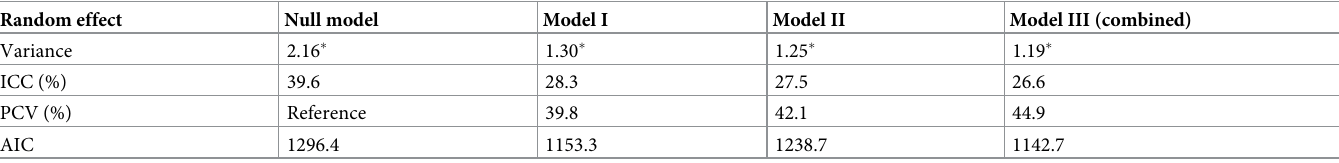
Table 1. Individual and community-level variances for multilevel random intercept Logit models predicting feeding 6–23 months age children with minimum acceptable diet in Ethiopia